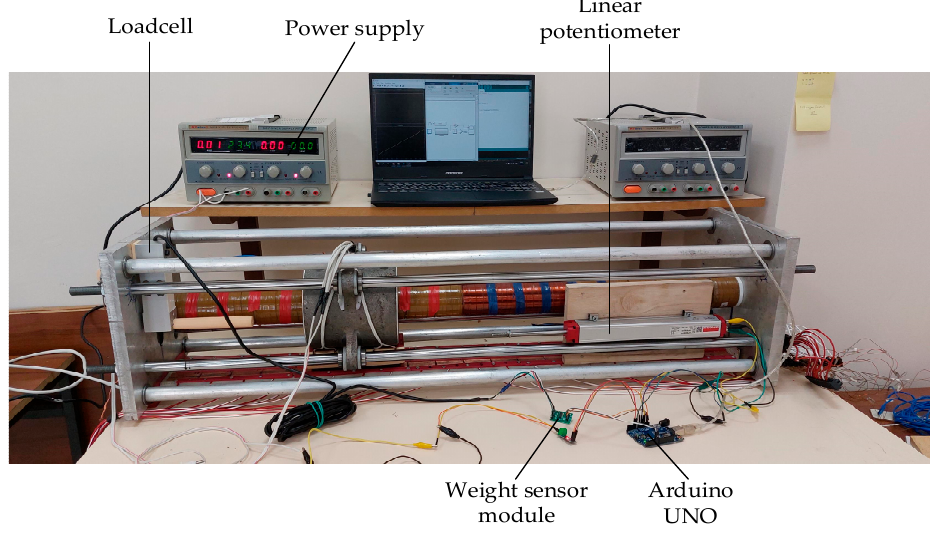
Figure 15. MATLAB/Simulink model of the system.